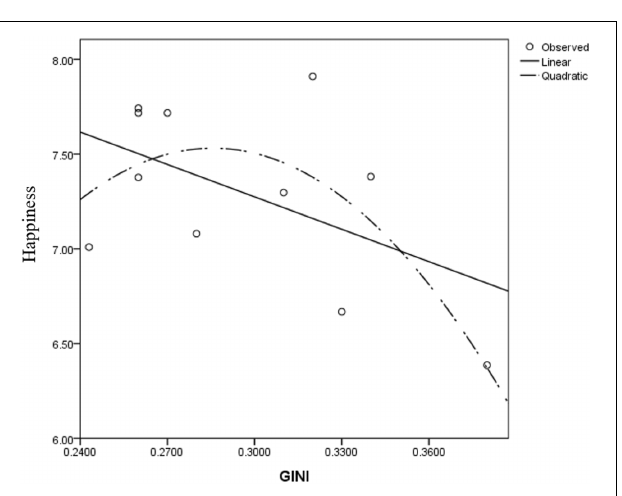
FIGURE 4 | Scatter plot of GINI-happiness for ESS, 2004.